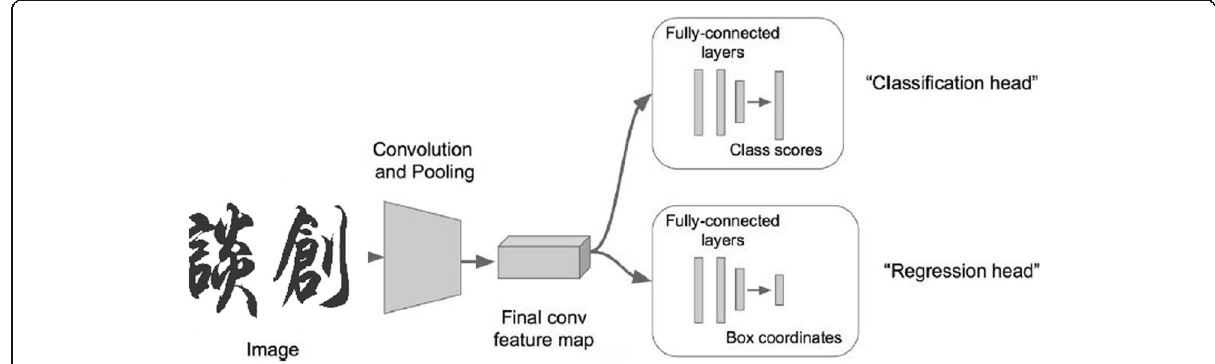
Fig. 4 Image classification and modeling based on deep convolution neural network